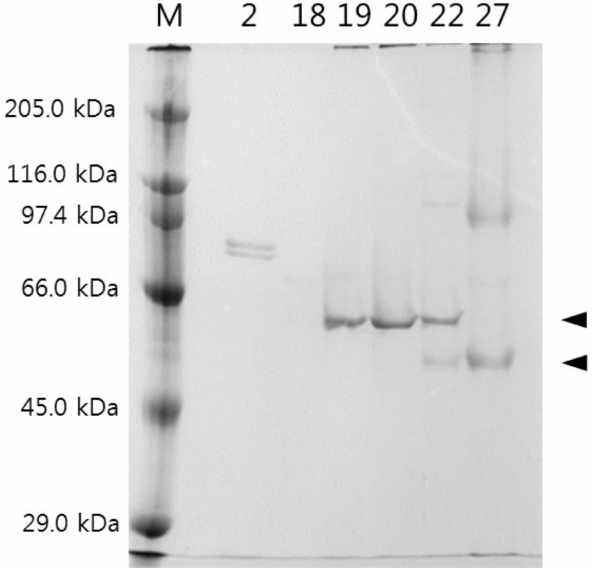
Figure 6. SDS-PAGE gel electrophoresis of fractions (tube numbers 2, 18, 19, 20, 22, 27) that showed CPI activity in the ion exchange chromatography. M: protein marker. Arrows indicate the protein bands (60 and 54 kDa) that were chosen for partial amino acid sequencing.